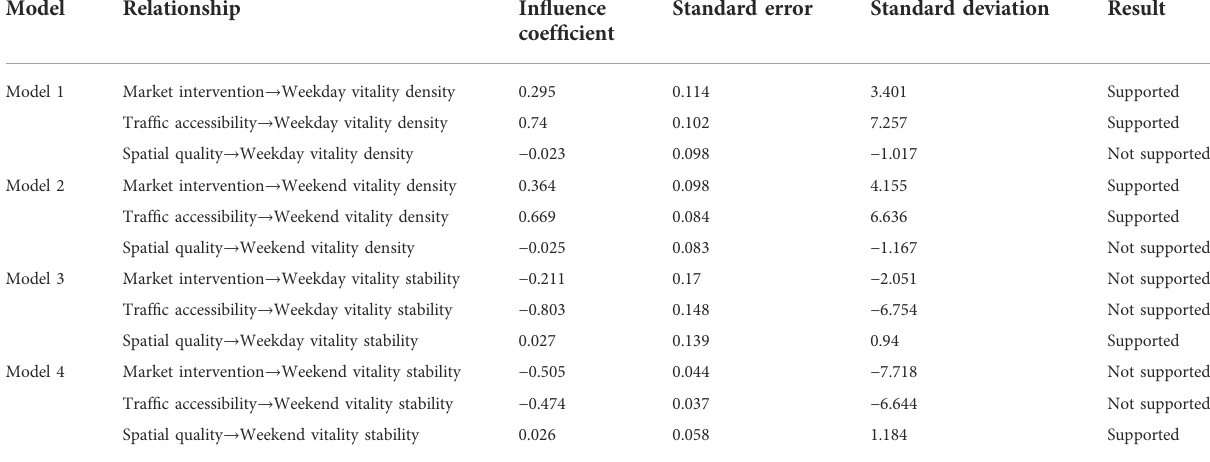
TABLE 6 Hypotheses